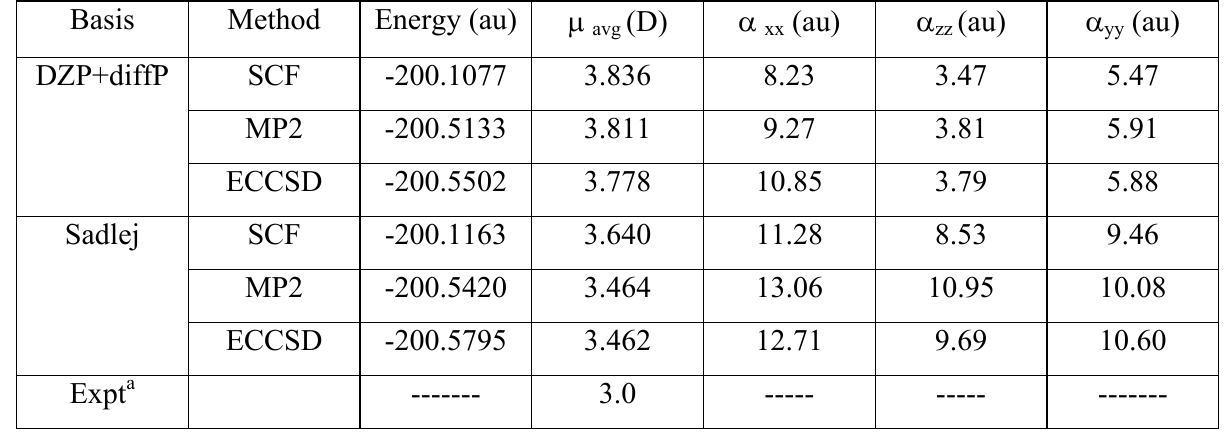
Table 4. Properties of HF dimer in different